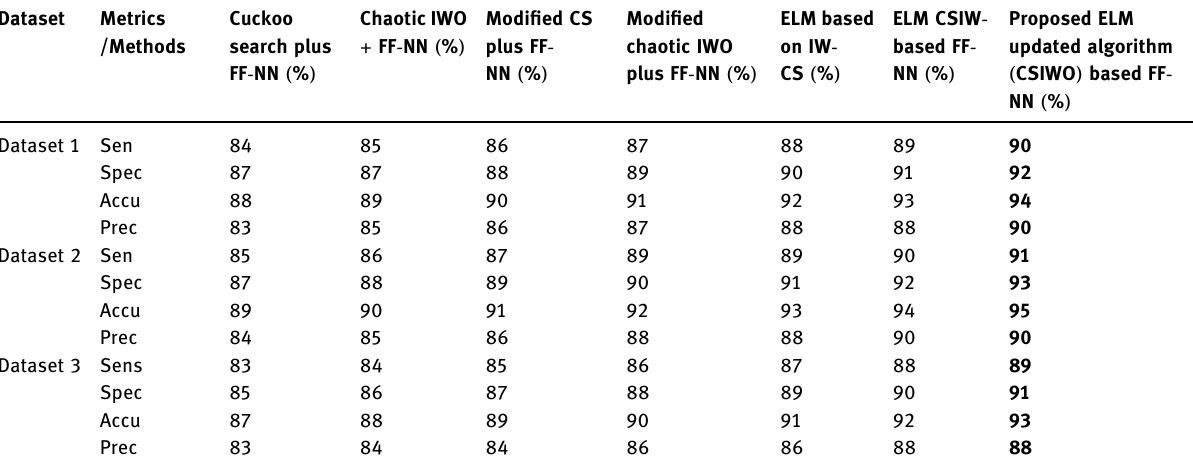
Table 1: Comparative discussion for linear value function Dataset